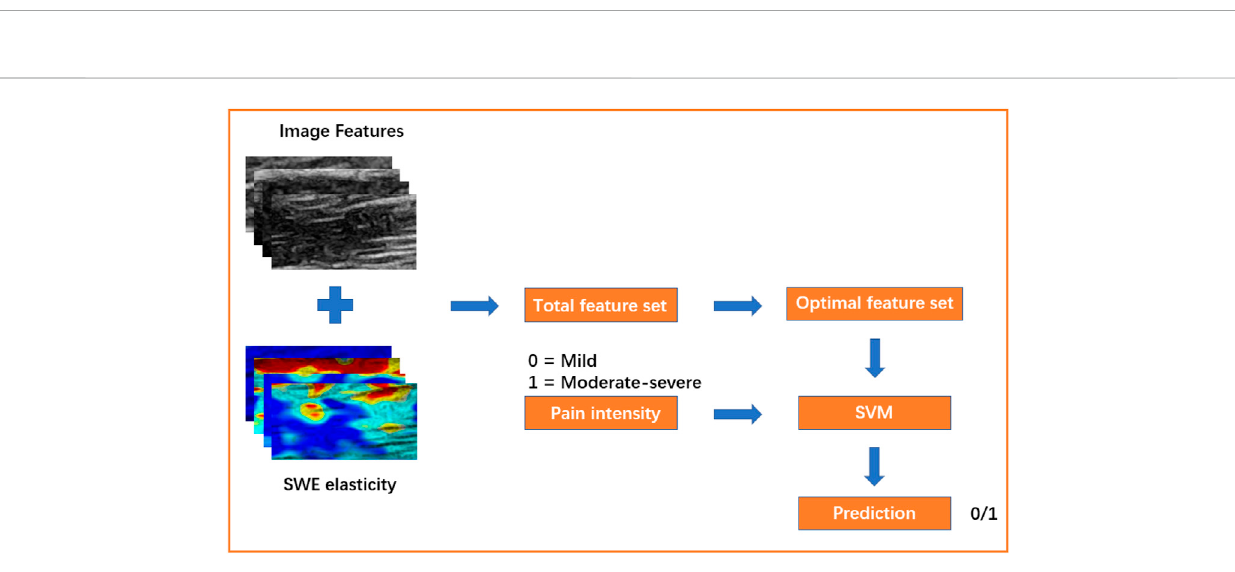
FIGURE 3 The framework of this experiment. Mild, NSLBP patients with a mild pain (VAS ≤ 3); Moderate-severe, NSLBP patients with a moderate-severe pain (VAS > 3); SVM, support vector